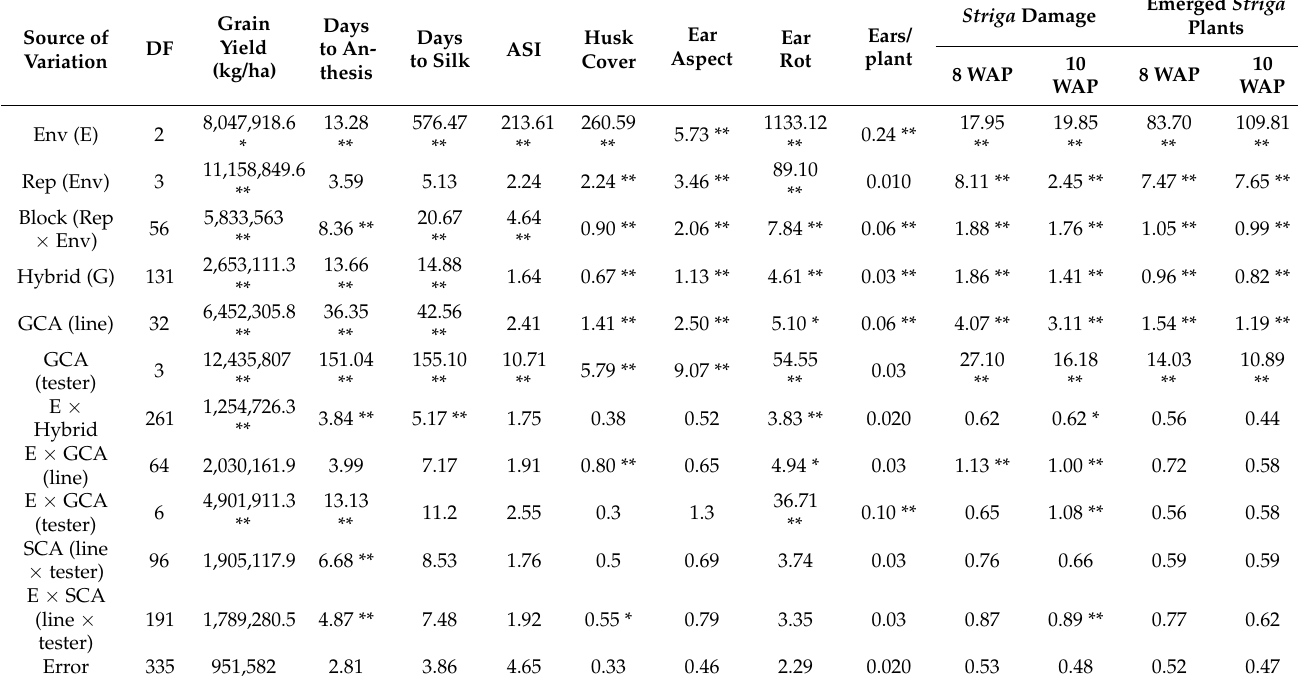
Table 2. Mean squares from the line × tester analysis of variance of grain yield and other traits of hybrids evaluated across three Striga -infested environments in Nigeria during the 2015 and 2016 growing seasons.